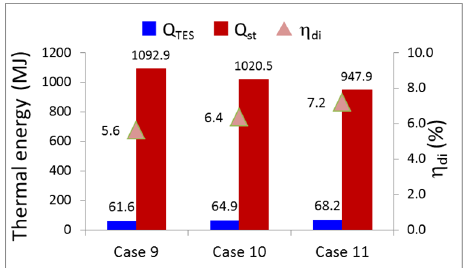
Figure 17. Transient discharging energy efficiency of the TES tank.